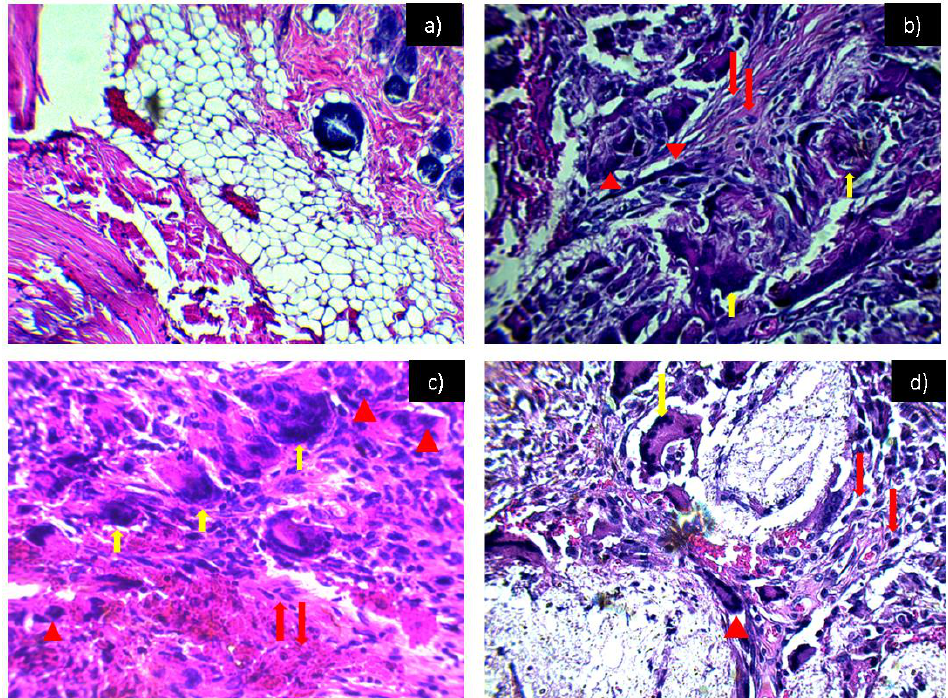
Figure 7. Histological preparation in tissue hematoxylin-eosin with the PCL/HA: ( a ) control, ( b ) PCL/HA 2 weeks, ( c ) PCL/HA 4 weeks, and ( d ) PCL/HA 6 weeks. Red arrows indicate the presence of lymphocytes, red arrowheads indicate macrophages, and yellow arrows indicate the presence of multinucleated giant cells characteristic of a chronic inflammatory infiltrate.